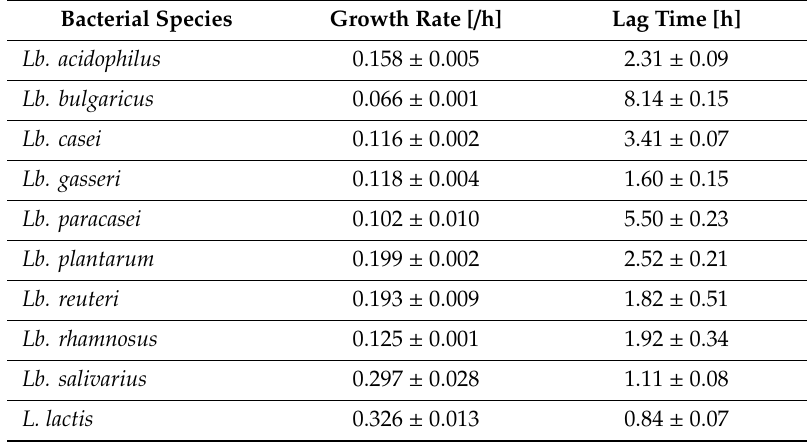
Table 3. Growth rates and lag times of the Lactobacillus spp. and L. lactis determined from their growth curves.